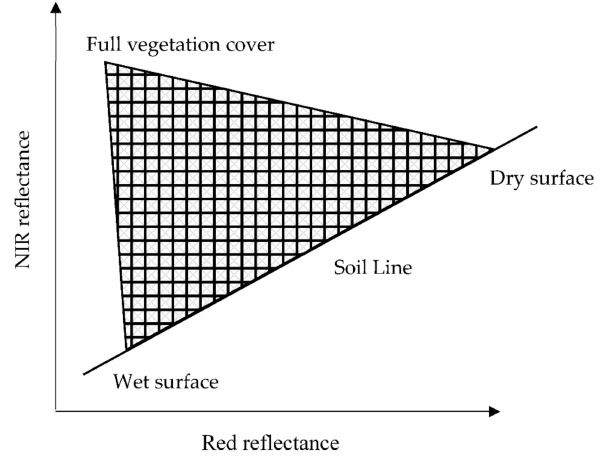
Figure 1. NIR/red triangular feature space. Adapted from [27]. Reprinted with permission from ref. [27]. Copyright 2011 Elsevier Ltd.